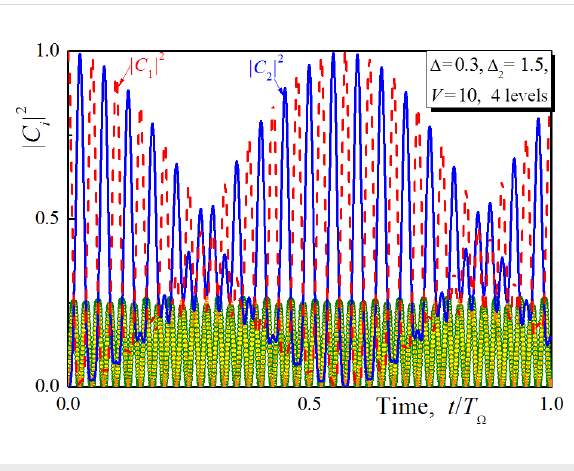
Figure 4: The time-dependent populations of states calculated when the 4th upper lying state of the superconducting system is involved in the Raman Λ -type transitions for Δ = 0.3, Δ 2 = 1.5 and V = 10. Dashed lines, solid lines, circles and squares are for | C 1,2,3,4 | 2 ,